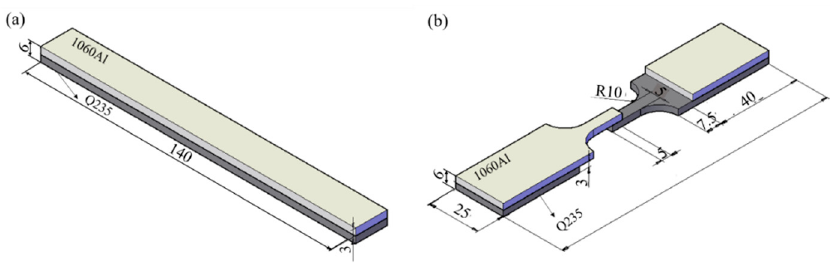
Figure 1. Dimensions of mechanical samples: ( a ) bending specimen and ( b ) shear specimen (unit: mm).